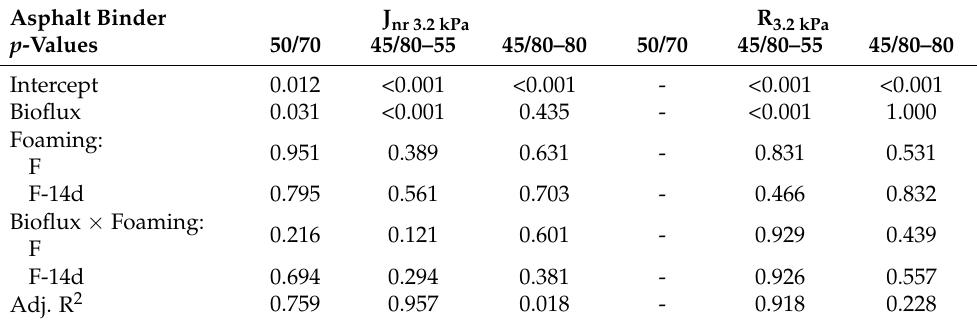
Table 6. The p -values calculated in analyses of variance for assessing the significance of the effects of Bioflux and foaming on the non-recoverable compliance and MSCR recovery of asphalt binders. Asphalt